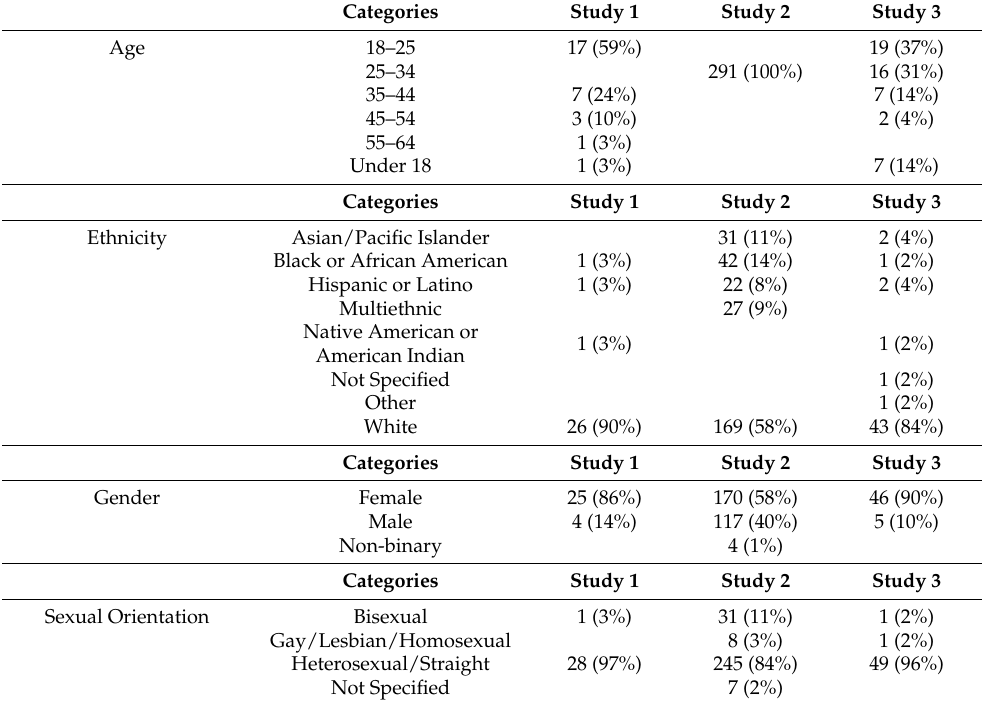
Table 2. Demographics of participants in all three